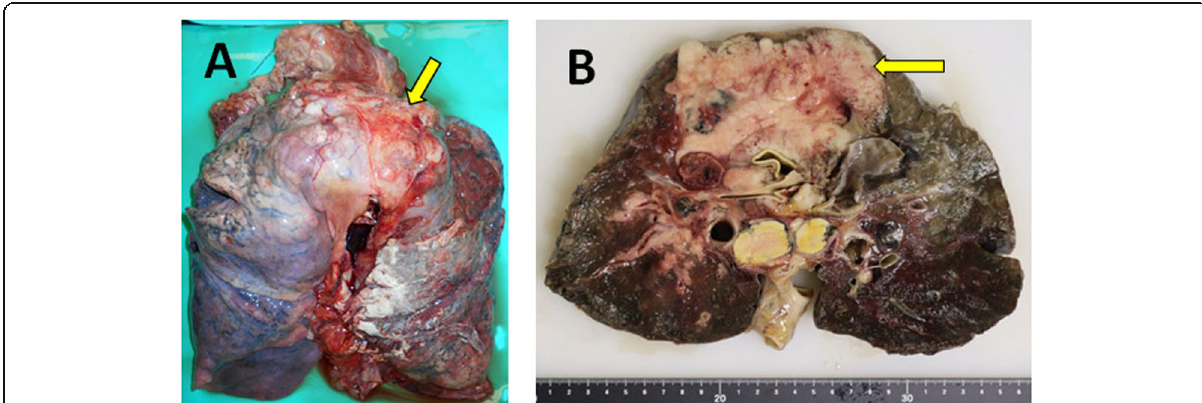
Fig. 1 Representative macroscopic image of the case at the time of autopsy. A Lung and anterior mediastinal tumor at excision. The yellow arrow indicates the anterior mediastinal tumor. B Cross-section of the lung and mediastinal tumor. The yellow arrow indicates anterior mediastinal